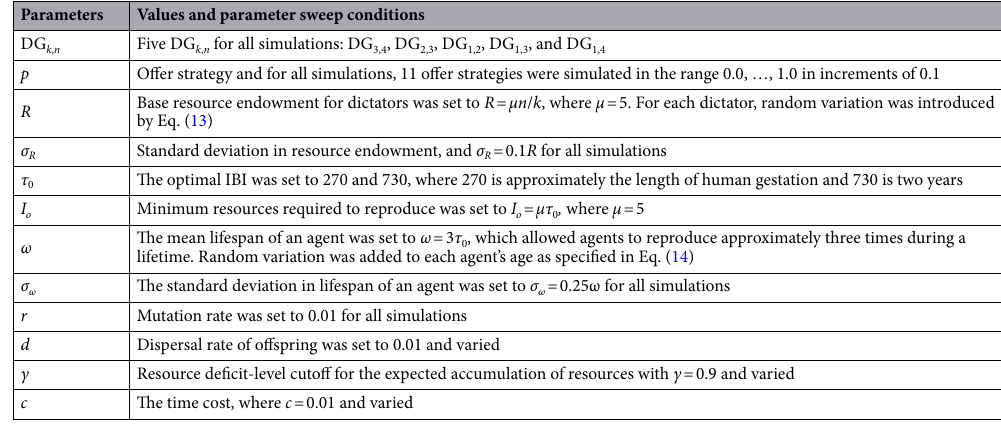
Table 1. Parameters and their interpretation used in the simple agent model and the agent-based